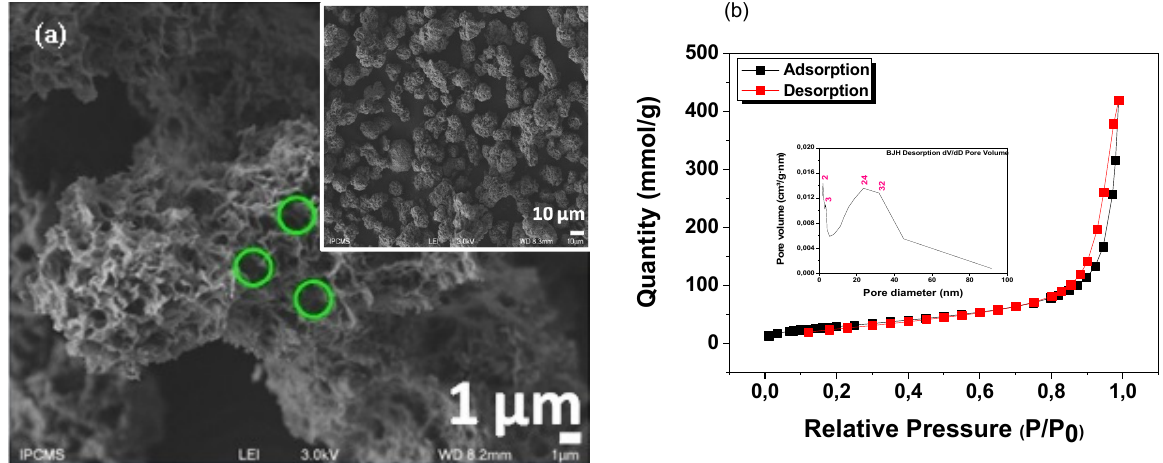
Figure 2. FESEM micrographs ( a ) and their N 2 adsorption-desorption isotherms (inset pore distribution) ( b ) of adsorbent based of Ni/Zn bi-phase nanohybrid.